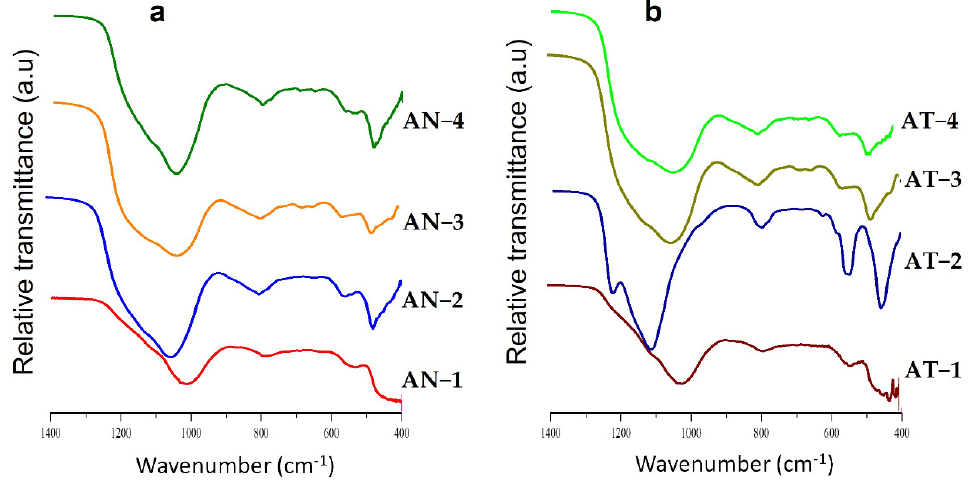
Figure 4. FTIR spectra of aluminosilicate synthesized using NaOH ( a ) and TPAOH ( b ).